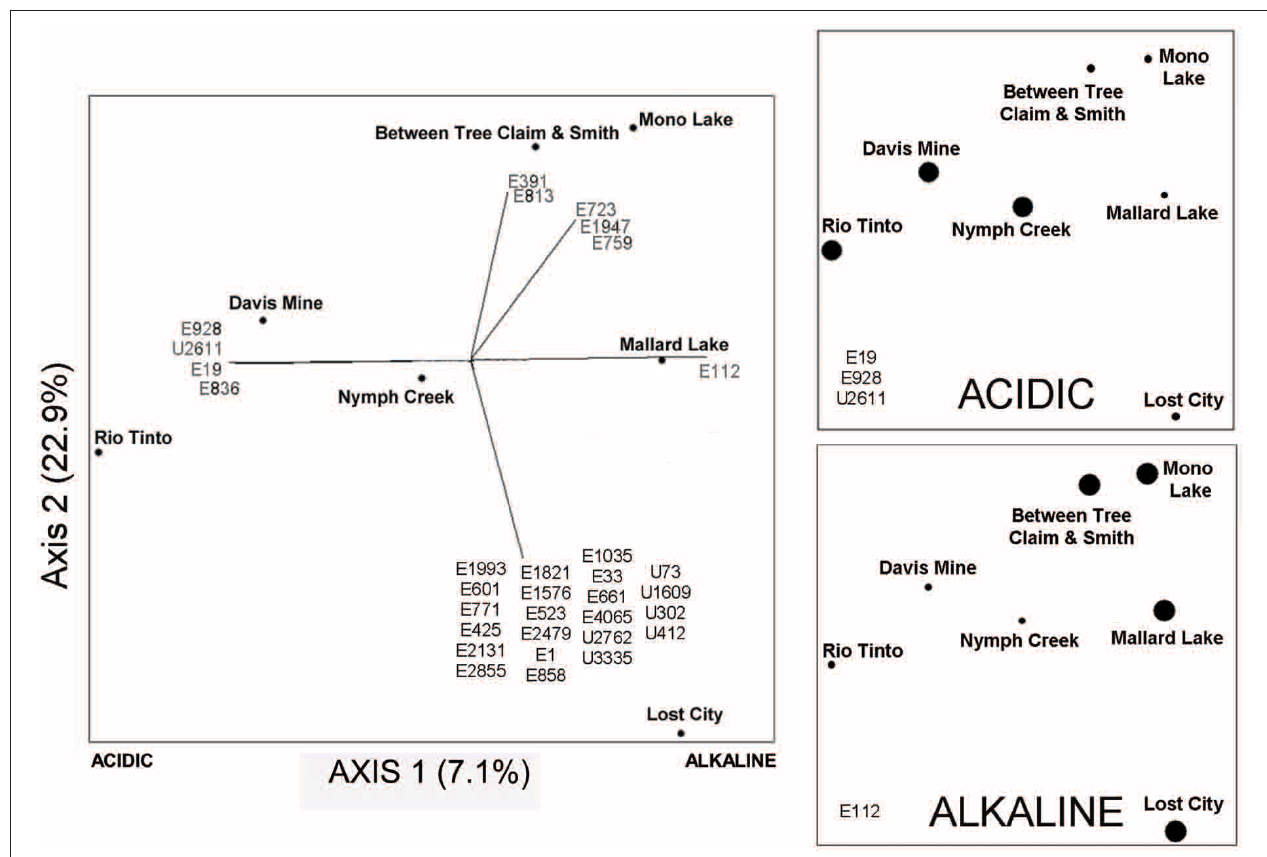
FIGURE 7 | NMDS plot on the left with Jaccard distances showing the proportion of variance contributed by each axis (calculated from the r 2 between distance in the ordination space and in the original space). Small circles on the left-hand plot show the location of all samples in the ordination. The two panels on the right show an overlay in the same ordination space of the “indicator” OTUs that are found in all acidic samples, upper panel (Rio Tinto, Davis Mine, and